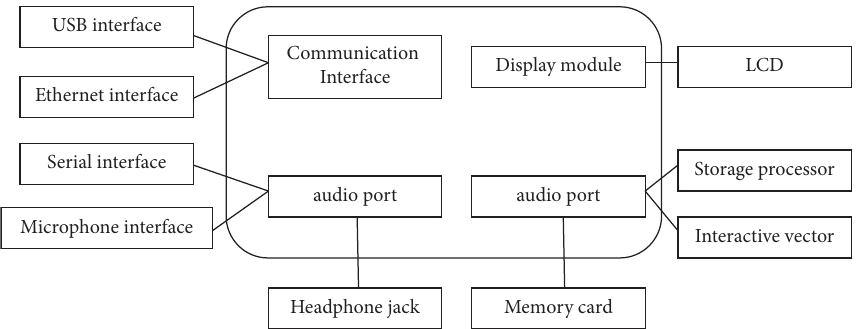
Figure 5: Multimedia recognition module of piano playing music.